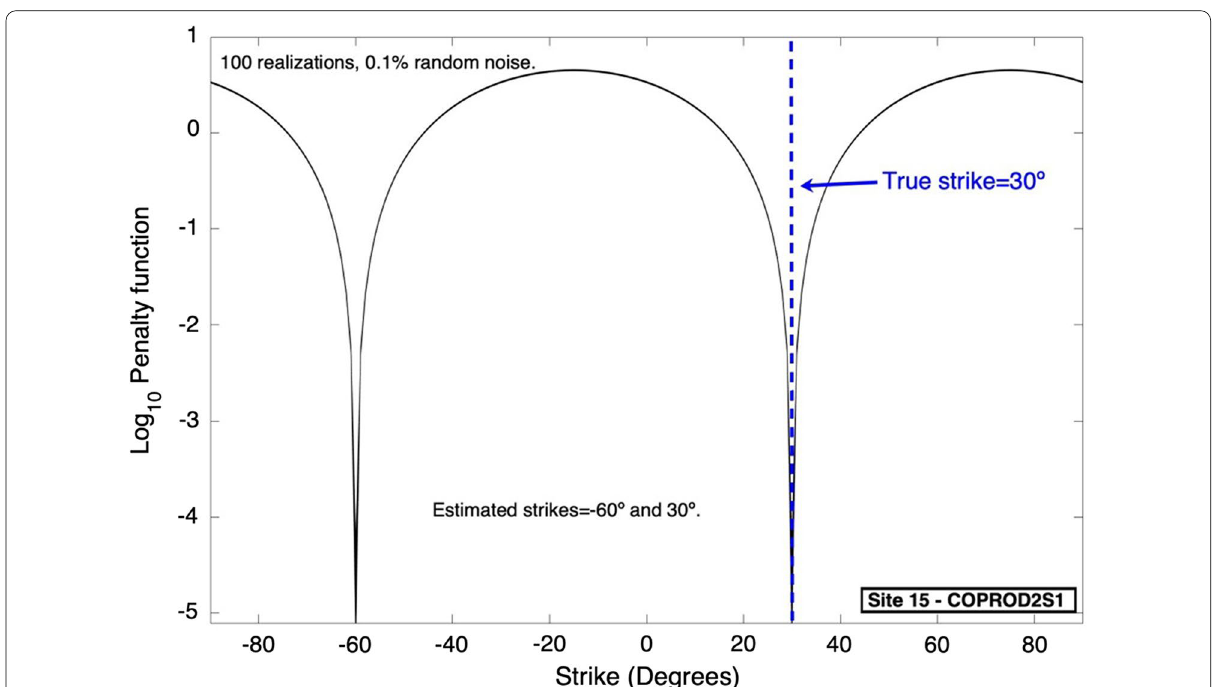
Fig. 2 Estimation of the strike using Eq. (7) for all available periods. We sampled the strike from and